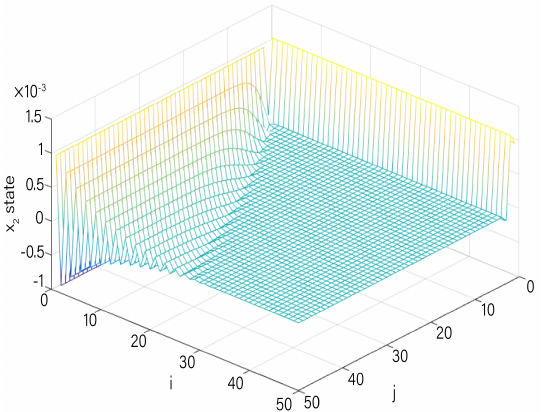
Figure 5. Closed-loop state space response of x 2 ( i , j ) when K = [0.01